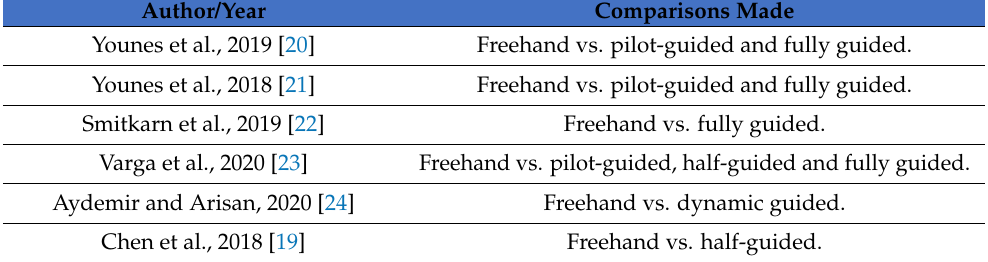
Table 1. Surgical techniques compared by study.